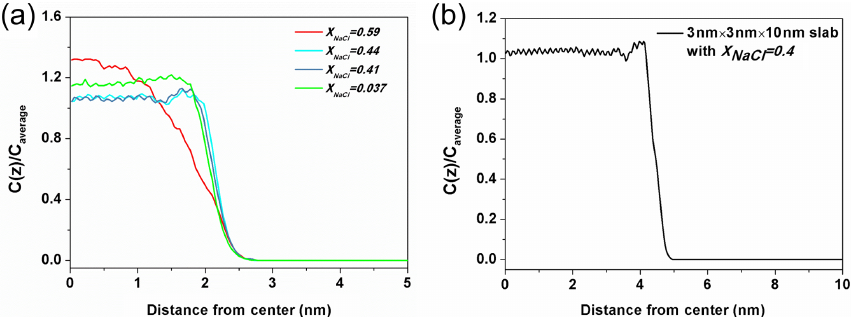
Figure 7. The ratio of Na + concentration at different positions ( C z ) to the average concentration of the whole system ( C average ). (a) The solution with x NaCl = 0 . 59 (red line) is on behalf of the solution in the molten NaCl-dominated regime (red line), the solution x NaCl = 0 . 44 and 0.41 (blue lines) represent the solution in transition regime and the solution x NaCl = 0 . 037 (green line) represents the solution in the water-dominated regime. (b) The density profile obtained from a 3nm × 3nm × 10nm solution slab in which NaCl mass fraction is about